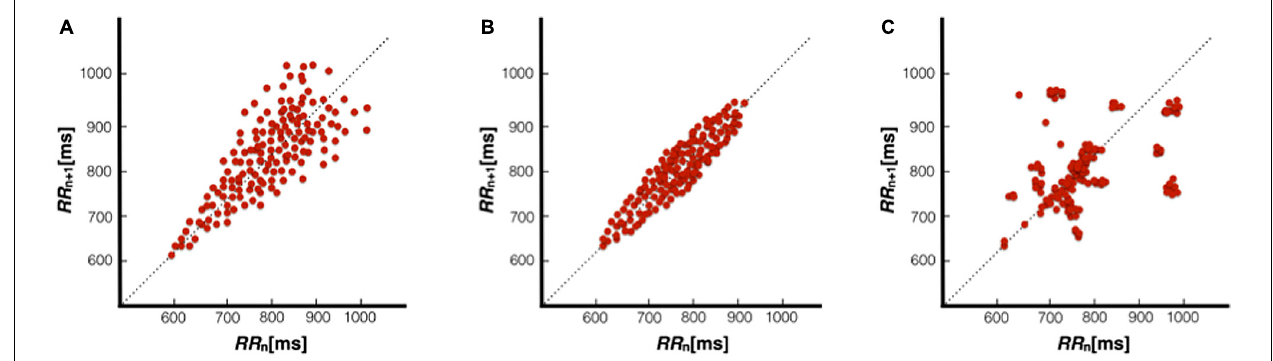
FIGURE 1 | Poincaré plots representative of a healthy individual with a comet pattern (A), heart failure patient with a torpedo pattern (B), and heart failure patient with a complex pattern (C). Figures adapted fromWoo etal. (1992).